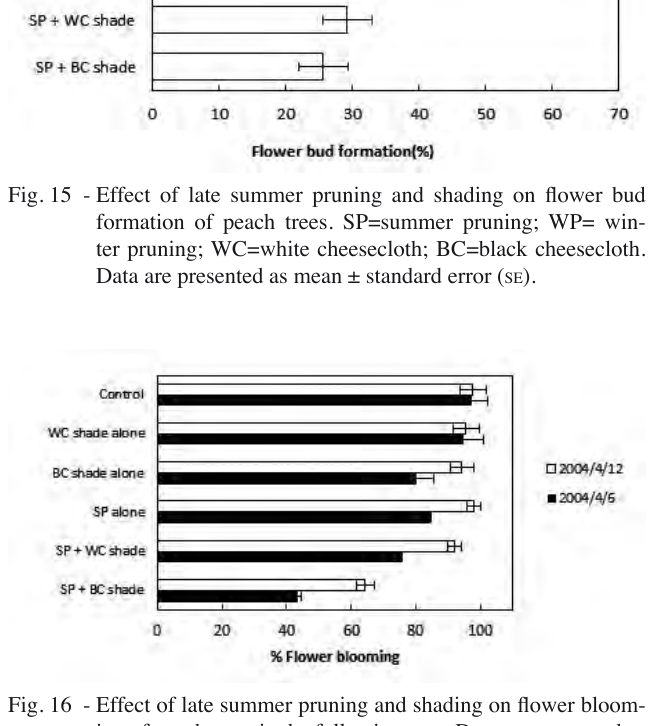
Fig. 16 - Effect of late summer pruning and shading on flower bloom - ing of peach trees in the following year. Data are presented as mean ± standard error ( se